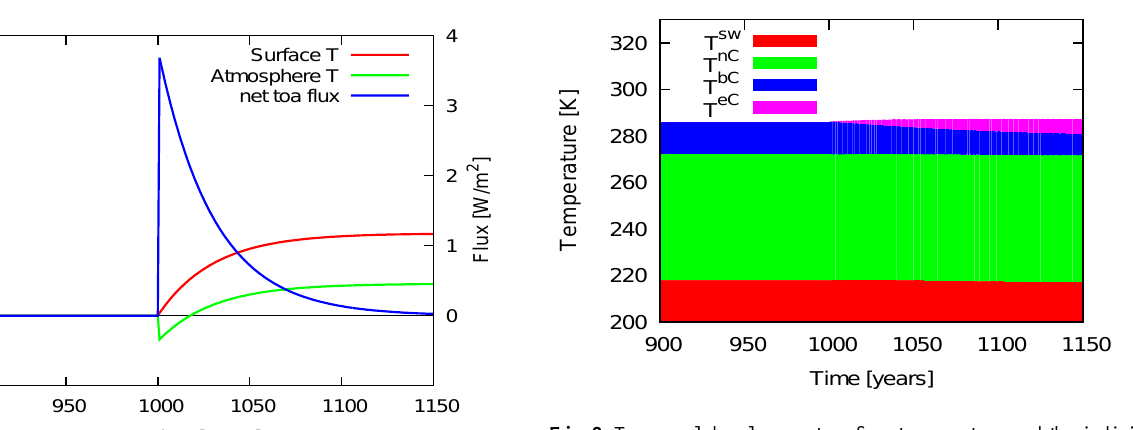
Fig. 8. Temporal development surface temperature and the individ- ual tagged surface temperatures (K) in an experiment, where after a 1000yr spin-up CO 2 concentration is